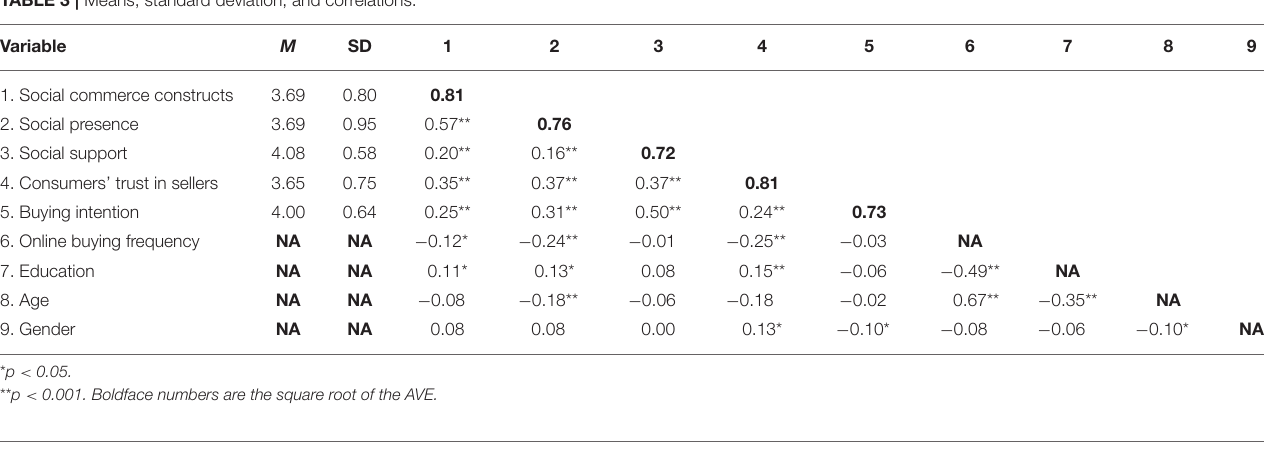
TABLE 4 | Comparison measure model and structural model. Absolute fit measures